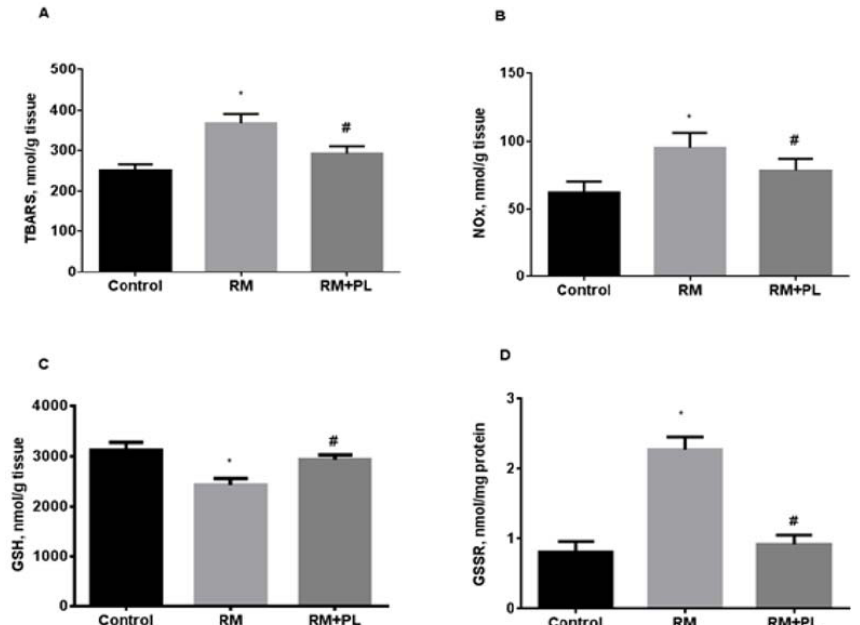
Figure 5. Oxidative stress in the renal tissue during rhabdomyolysis and PL administration: ( A ) levels of TBA ‐ reactive substances (TBARS, nmol/g tissue); ( B ) total nitrates and nitrites (NOx, nmol/g tissue); ( C ) levels of reduced glutathione (GSH, nmol/g tissue); ( D ) levels of mixed protein disulfides with glutathione (GSSR, nmol/mg protein). * p < 0.05 compared to control, # p < 0.05 compared to RM.